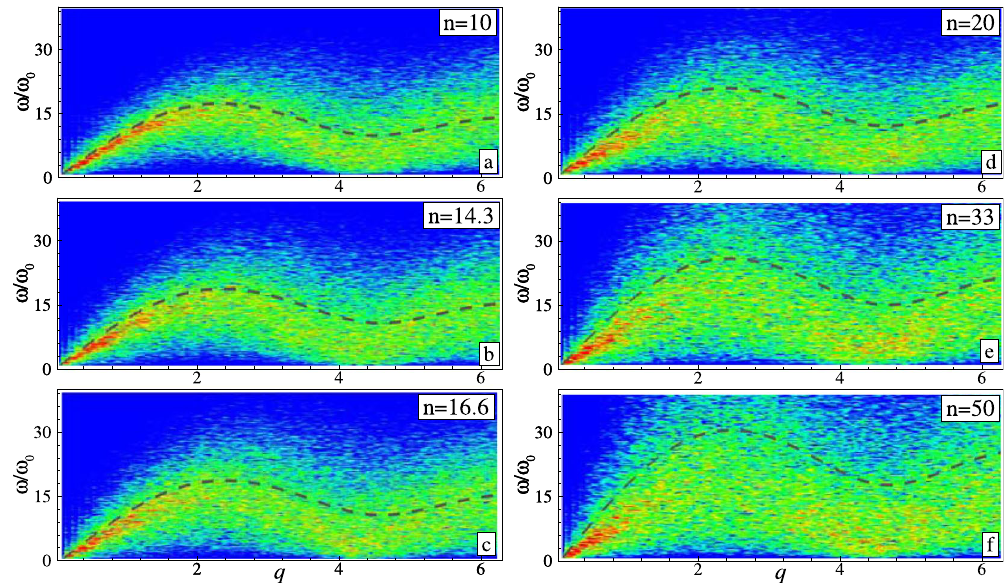
Figure 2. Dispersion relations of the longitudinal mode in IPL melts. The frequency is measured in units of ω = v a / , where = v T m / is the thermal velocity, the wave-number is in units of a − 1 , q = ka . The color 0 T T background corresponds to the longitudinal current fluctuation spectrum from MD simulations (the intensity increases from blue to red). The dashed lines are the results of calculation using QCA model with g ( r ) obtained in MD simulations. The results are shown for six different IPL exponents: = n 10 ( a ), .  n 14 3 ( b ), .  n 16 6 ( c ), n = 20 ( d ),  n 33 ( e ), and n = 50 ( f